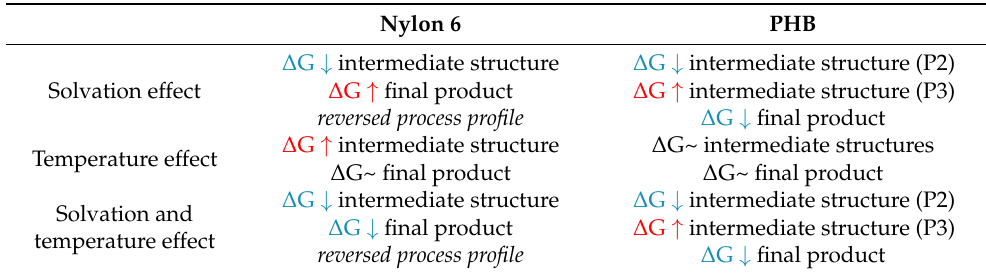
Table 1. Summary of investigated external conditions’ effect on the thermodynamic profiles of nylon 6 and PHB thermal degradation processes.